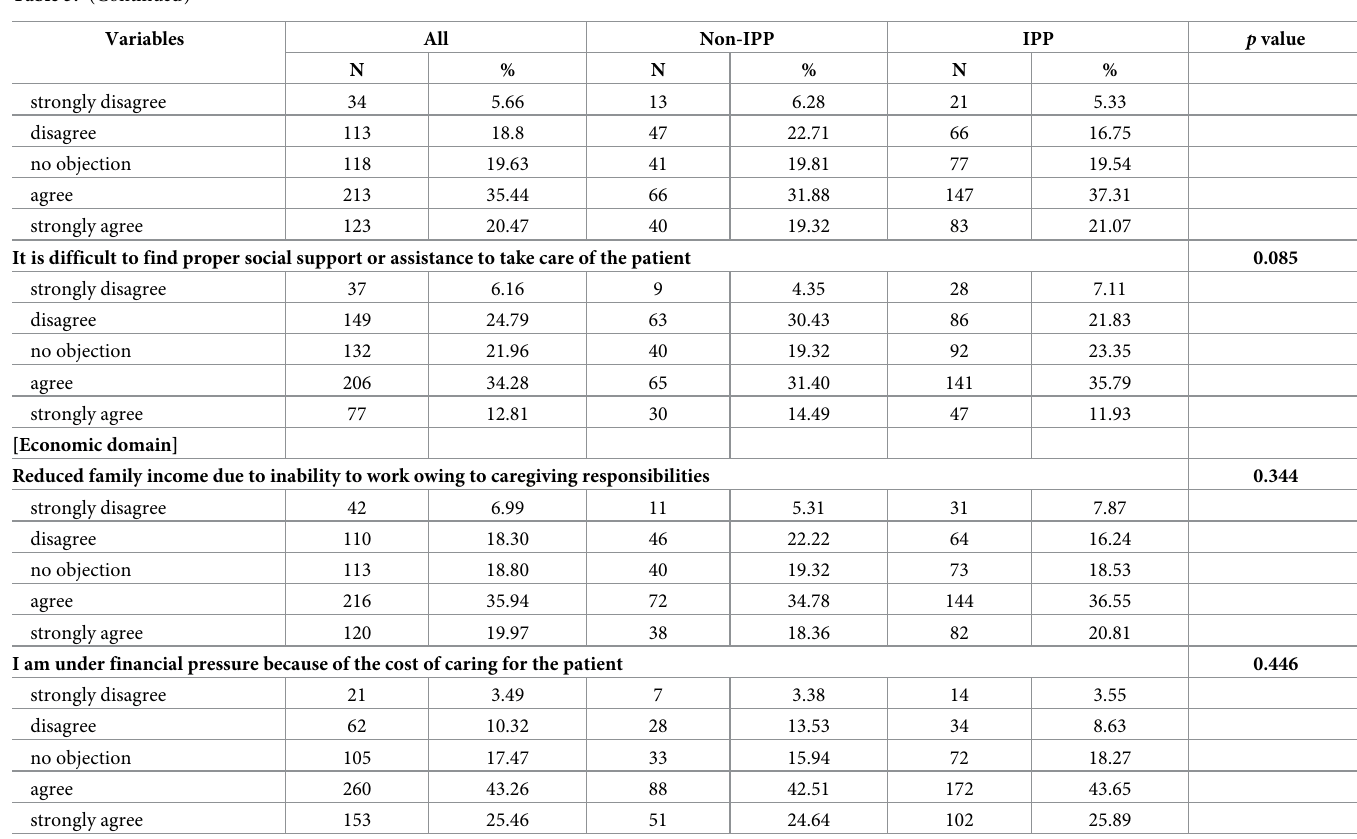
main caregivers of home-based PMV patients [20, 22, 29, 30, 32, 33], we cannot ignore the stress experienced by caregivers of ICU patients.